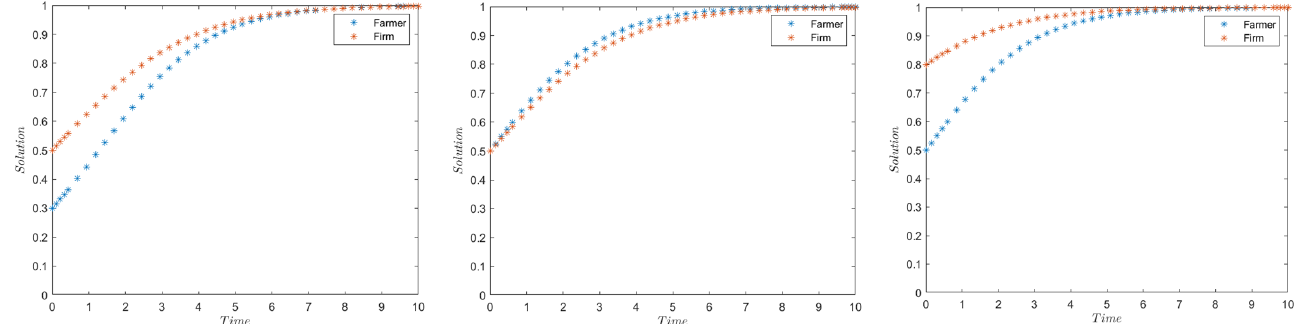
Figure 2. Dynamic evolution diagram of the strategy selection of farmers and enterprises.